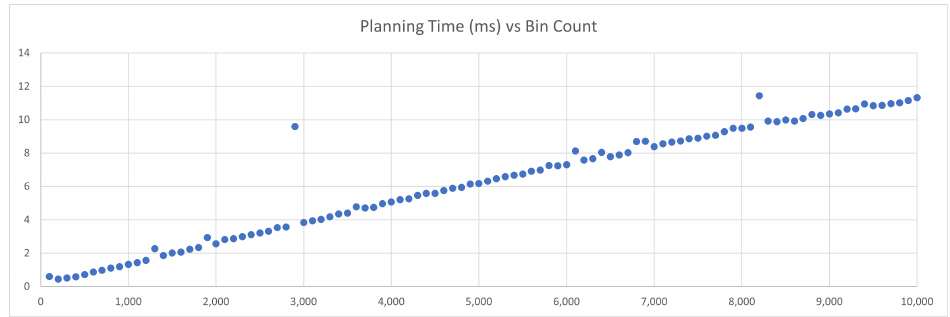
Figure 6. Query planning time (ms) vs. the number of histogram bins in Algorithm 2.